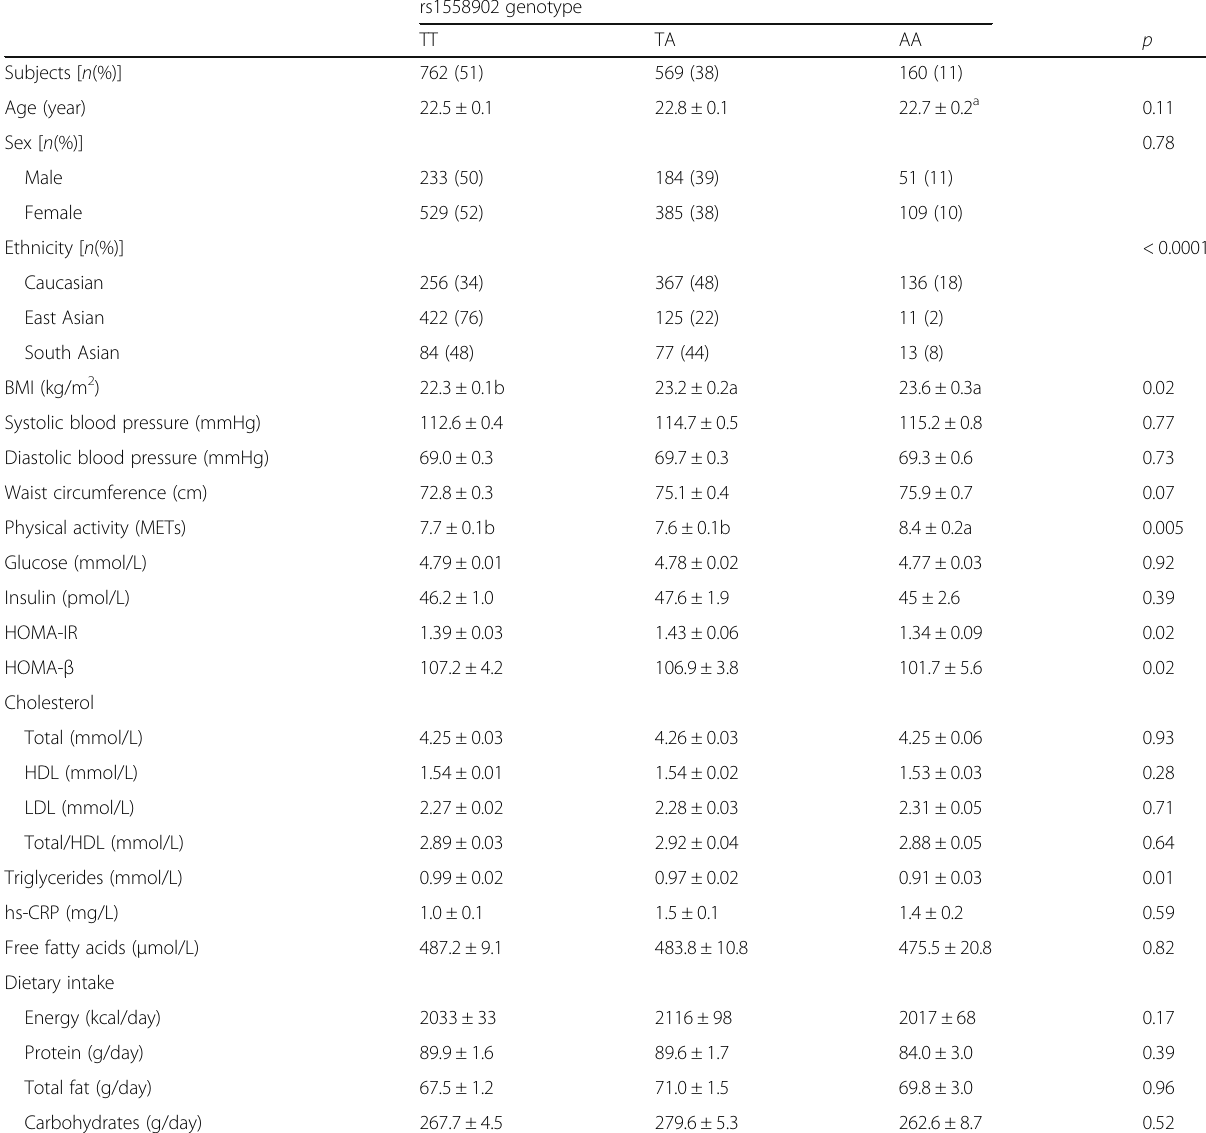
Table 1 Subject characteristics by FTO genotype